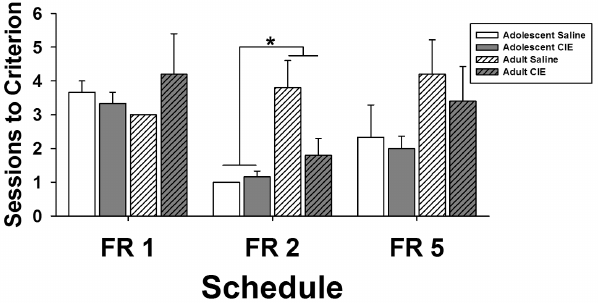
Figure 7. Effects of chronic intermittent ethanol or saline exposure during adolescence or adulthood on number of training sessions required to meet criteria for advancement in each of the three Fixed Ratio (FR) training schedules. Data are expressed as group mean + SEM (n=6 adolescent-saline, n=6 adolescent-CIE, n=5 adult-saline, n=5 adult-CIE). Asterisk denotes a difference in the number of training sessions required to reach criterion for rats exposed to CIE/saline as adolescents compared to rats exposed to CIE/saline as adults independent of CIE exposure (simple effects ANOVA, p , 0.05).